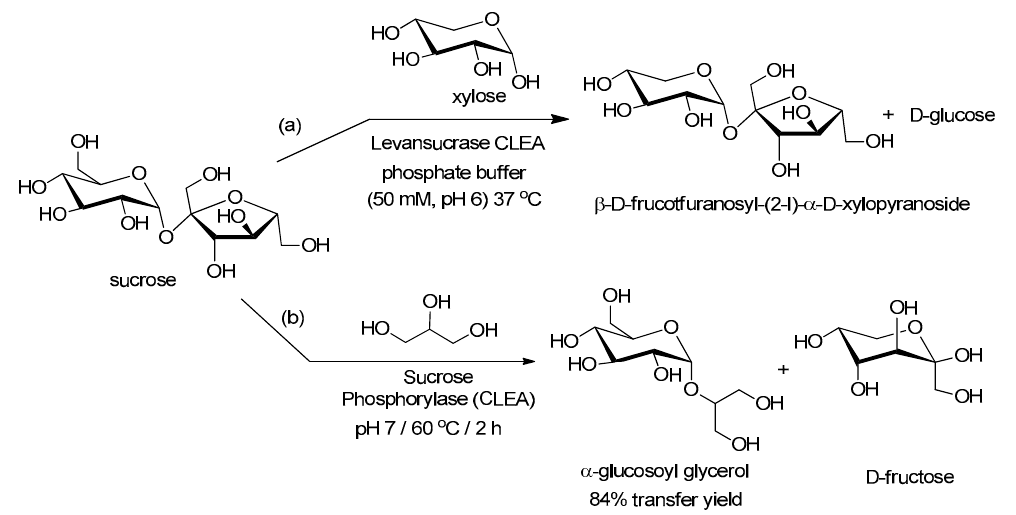
Figure 3. CLEA-catalyzed transglycosidations.